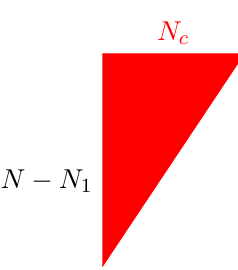
Figure 6 . Typical Young tableau consisting of N 1 fermions in the Fermi sea and N (cid:0) N 1 fermions describing a localised superstar made of N c giant gravitons (red